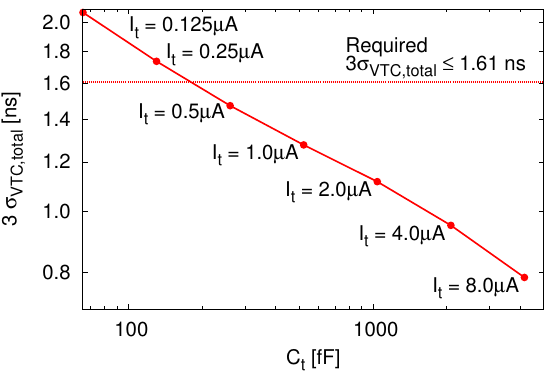
Figure 13. 100-times transient-noise simulation result of 3 σ VTC , total vs. C t